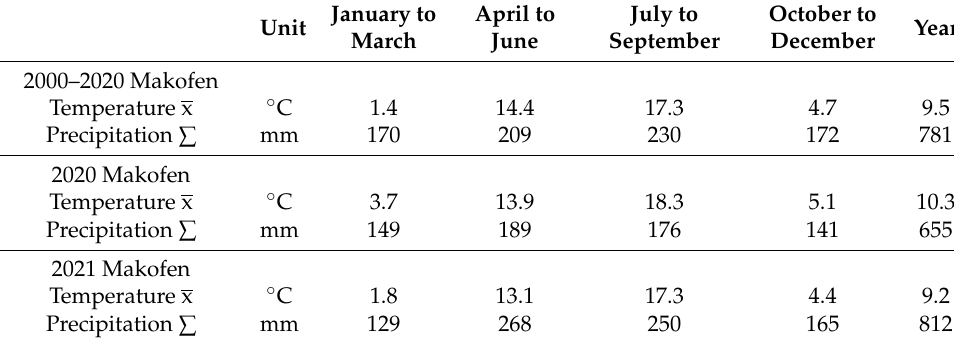
Table 2. Mean temperature and precipitation—Makofen Research